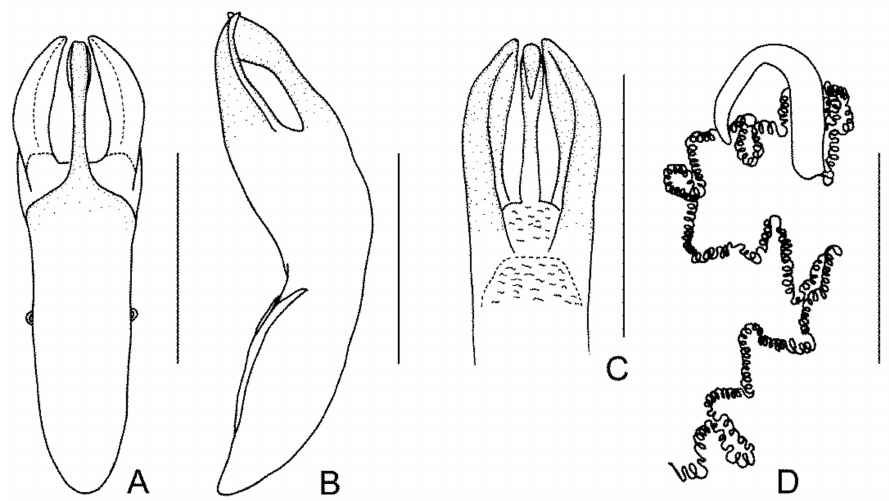
Figure 23. Cryptocephalus ( Burlinius ) nebulo Weise, 1889: ( A ) dorsal view of aedeagus; ( B ) lateral view of aedeagus; ( C ) part aedeagus of ventral view; ( D ) spermatheca (Scale bars: 0.5